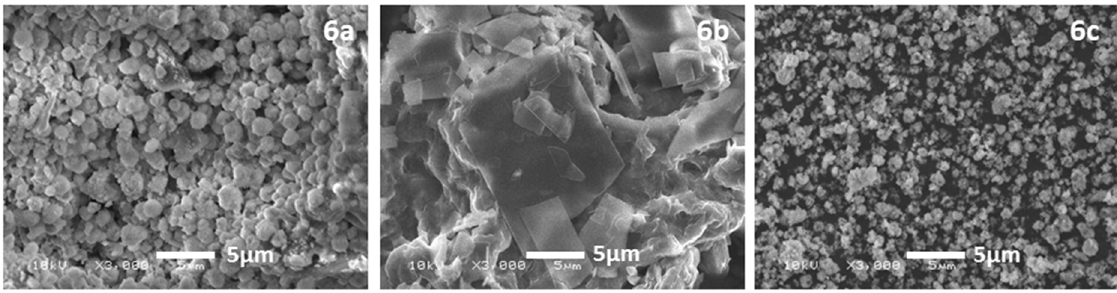
Figure 1. SEM micrographs of 6a , 6b and 6c .